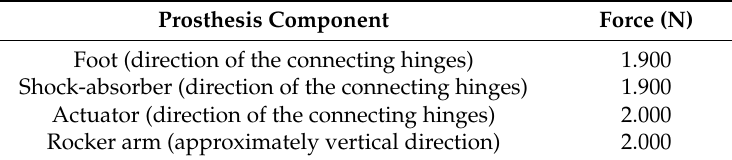
Table 3. Maximum force transmitted to the hinges of the prosthesis in a gait cycle.